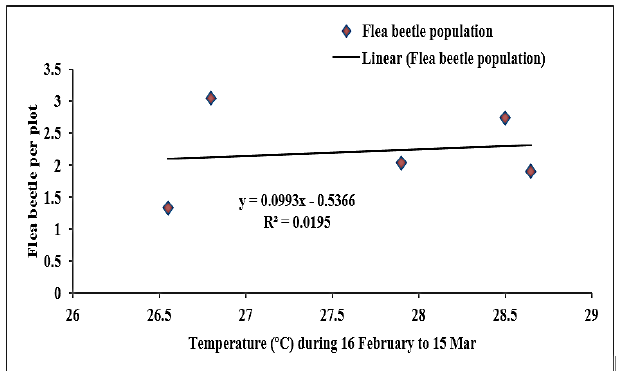
Figure 3: Relationship between the population of flea beetle and